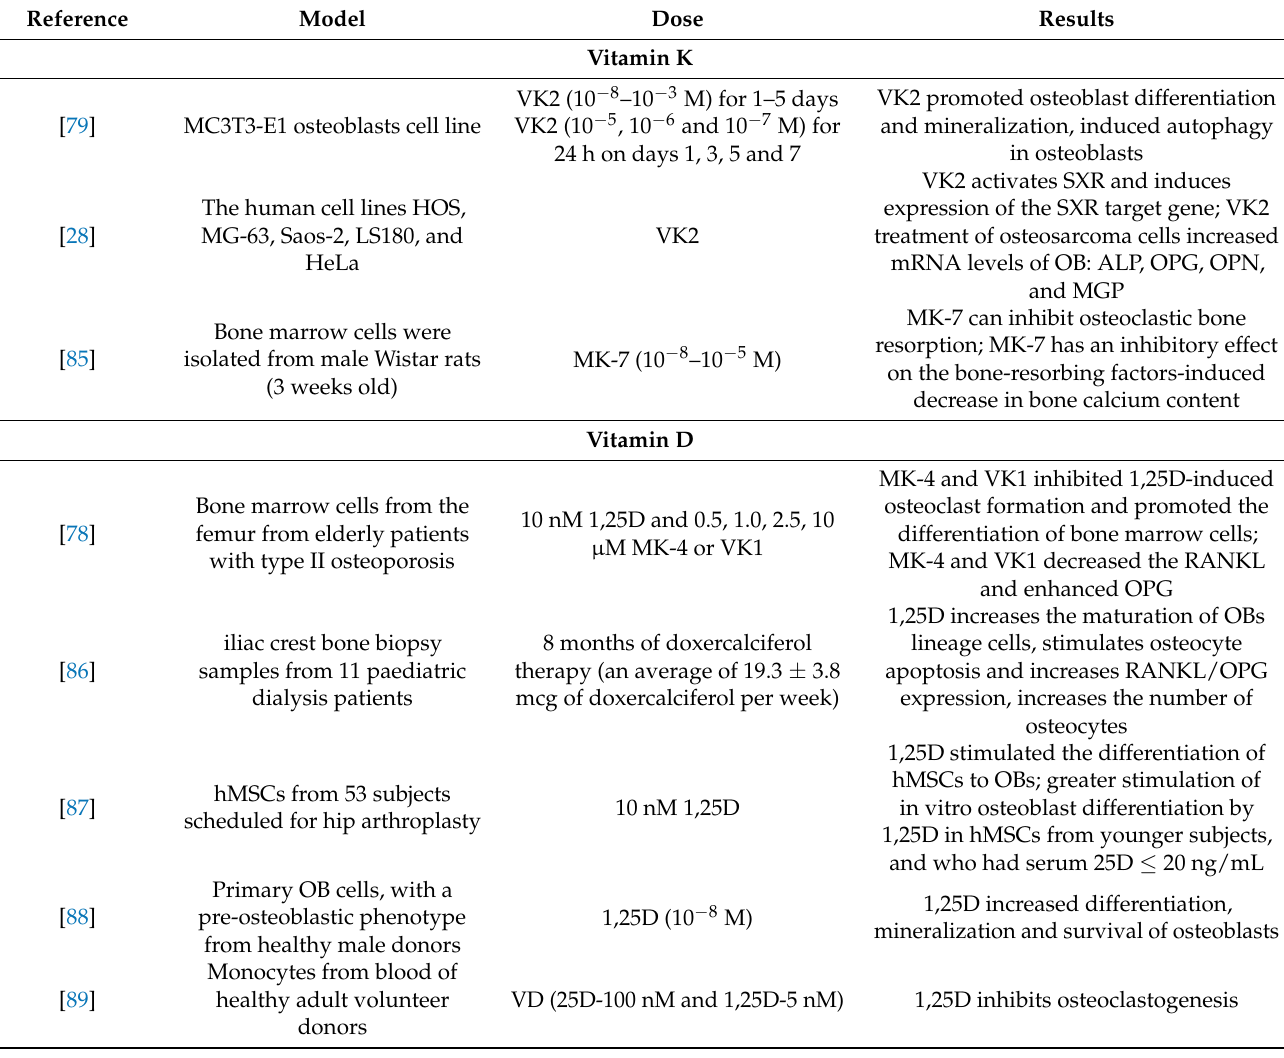
Table 1. Role of vitamin K and vitamin D in bone remodeling in chronic kidney disease (CKD): pre-clinical evidence.